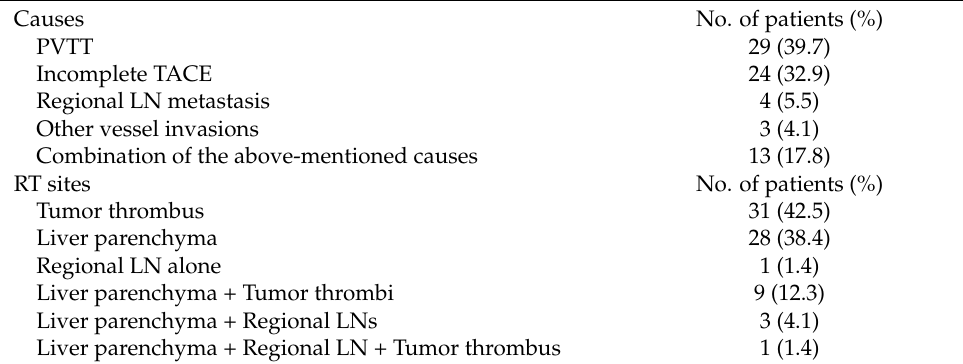
Table 2. Causes of RT administration and specifications of RT